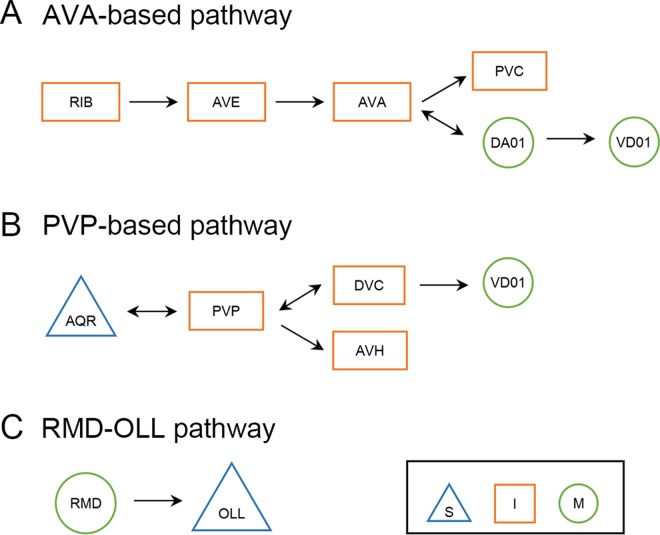
Three main critical synapse pathways as determined by the Vulnerability analysis for average betweenness (VB).Three main pathways for VB: the AVA-based, the PVP-based, and the RMD (M) → OLL (S) pathways (S: Sensory neuron, I: Interneuron, M: Motor neuron). These three main pathways emerged from the critical synapse analysis and well capture the converged findings from both the critical neurons and synapse vulnerability analyses. (A) The first AVA-based pathway begins with RIB (I) → AVE (I) → AVA (I) and has two routes after this: (a) AVA (I) ←→ DA01 (M) → VD01 (M) (ending at VD01 since VD01 → DVC (I) is inhibitory); and (b) AVA (I) → PVC (I). For route (b) (RIB (I) to PVC (I)), we found that average network betweenness centrality (i.e., XB(i,j)) actually increased with the AVAL/R (I) → PVCL (I) synapse removals (VB(i,j) had negative values without taking the absolute values). This suggests that the loss of the AVA → PVC connection leaves greater differences among the remaining alternative routes to PVC, perhaps leaving the well-established forward locomotion circuit as the main throughway (i.e., AVB (I) → PVC (I)). (B) The second PVP-based pathway, begins with AQR (S) ←→ PVP (I) and has two routes after this: (a) AQR (S) ←→ PVP (I) ←→ DVC (I) → VD01 (M); and (b) AQR (S) ←→ PVP (I) → AVH (I). We also note that the inhibitory projection of VD01 (M) → DVC (I) suggests a separation of the AVA- and PVP-based pathways and a competitive relationship between them. (C) The RMD (M) → OLL (S) link was also identified as a critical pathway segment.